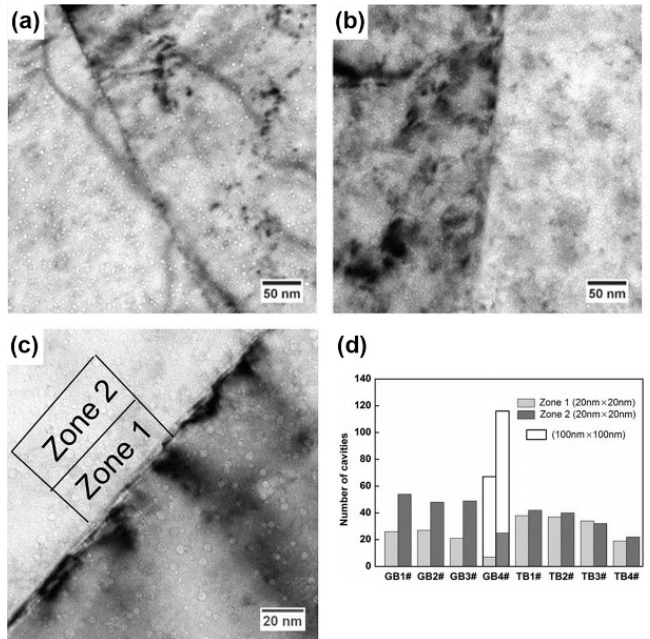
Figure 16. ( a , b ) Cavities near general a grain boundary and twin boundary in Cu after He ion irradiation. ( c ) high-magnification micrograph of the cavities near the twin boundary. ( d ) Statistical data of the cavities number adjacent to two types of the boundaries [51].